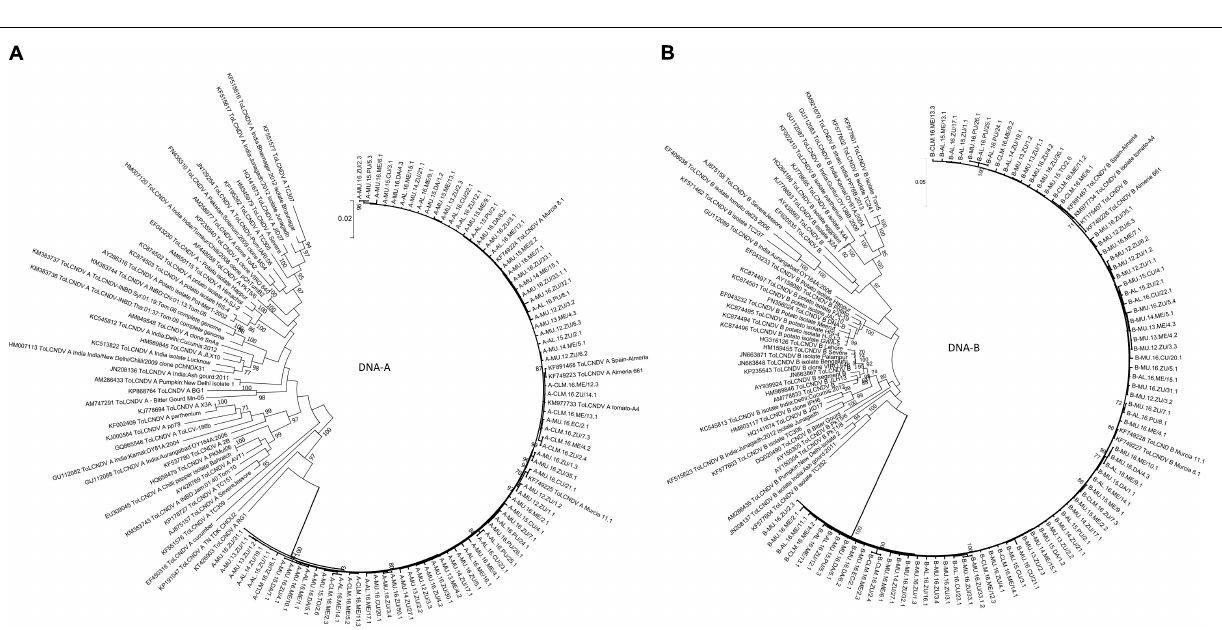
FIGURE 2 | Phylogenetic trees of the 80 ToLCNDV consensus nucleotide sequences. The phylogenetic analysis was inferred by Maximum Likelihood, using the full-length genome A (left) and B (right) of the ToLCNDV isolates of this study, including a collection of 50 full-genome ToLCNDV sequences retrieved from NCBI-GenBank (referenced according to their accession number), with also full-length ToLCNDV sequences from Spain available to date. Each ToLCNDV isolate from this study was referenced according to its location (MU, Murcia; AL, Alicante; CLM, Castilla-La Mancha), year (2012–2016), host (ZU, Zucchini; ME, Melon; PU, Pumpkin; CU, Cucumber; DA, D. stramonium ), as well as the plot and sample number. The bootstrap values corresponded to 1,000 replications, and the scales provide genetic